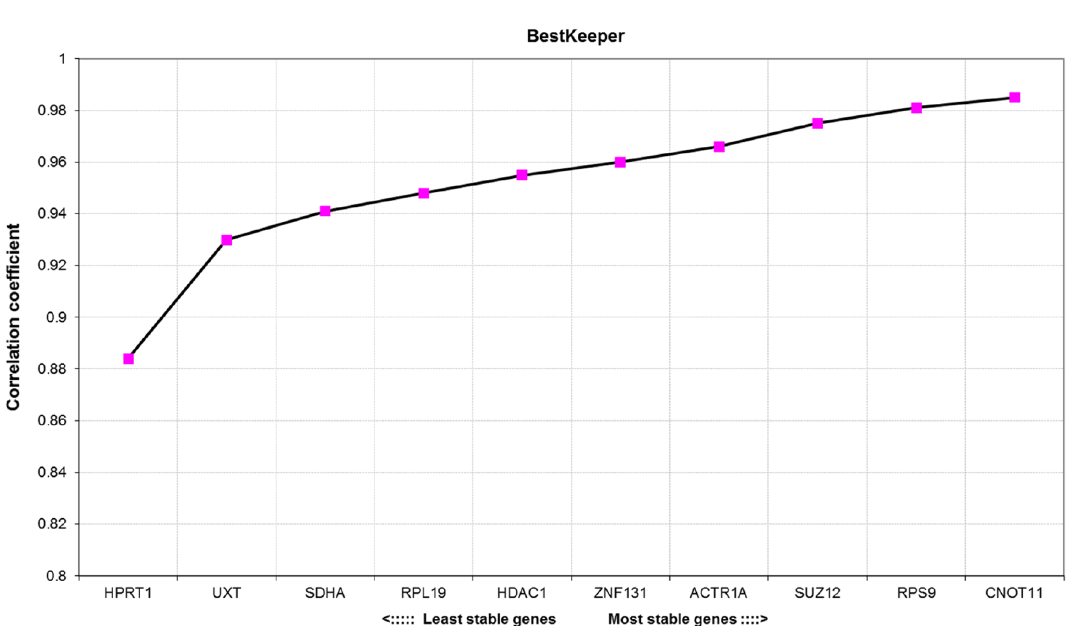
Figure 3. Correlation coefficient ( r ) of candidate reference genes calculated by the BestKeeper algorithm. The higher the correlation coefficient, the more stably is the gene expressed in the tested